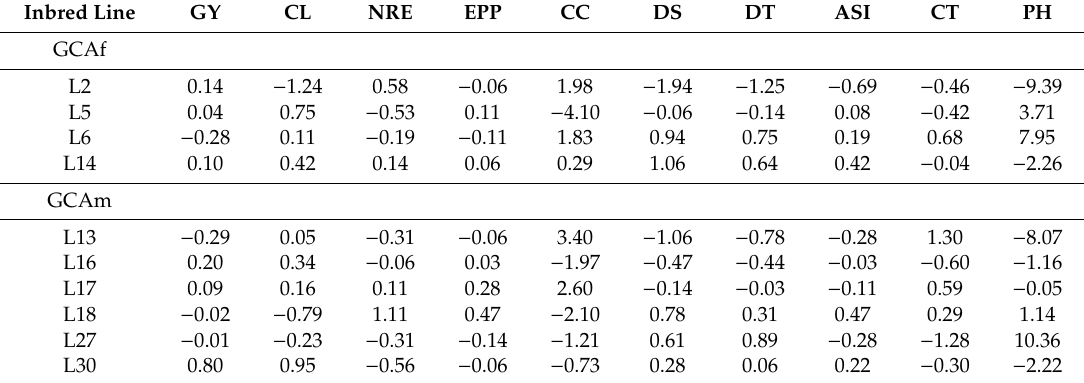
Table 6. General combining ability e ff ects for yield, yield components and other morpho-agronomic traits under optimum conditions. Inbred Line